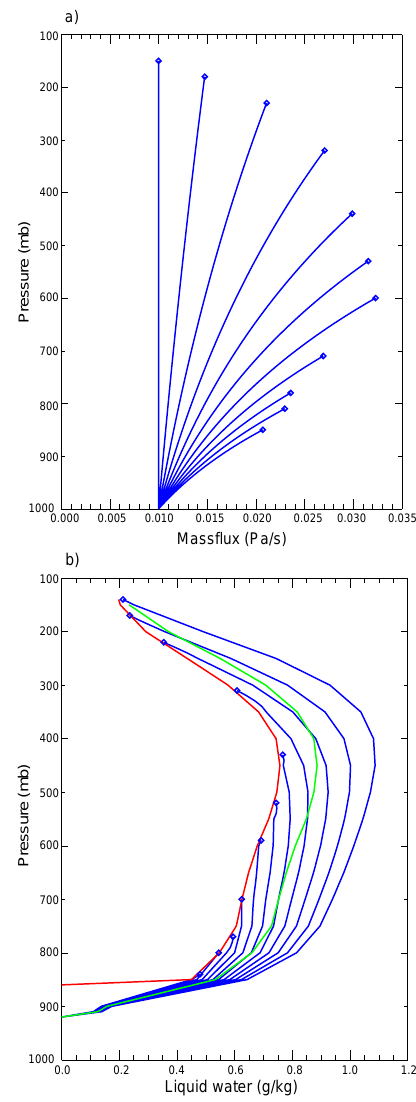
Fig. 1. (a) Vertical profiles of mass flux for entraining plumes launched into the Jordan (1958) sounding. Each plume has an arbi- trary updraft-base mass flux of 0.01Pas − 1 and a range of entrain- ment rates are used to produce a range of detrainment levels, these being indicated by the diamond symbol. (b) The corresponding pro- files of plume liquid water (blue lines). Also shown are the profiles of detrained liquid water (red line) and the bulk liquid water for the plume ensemble (green